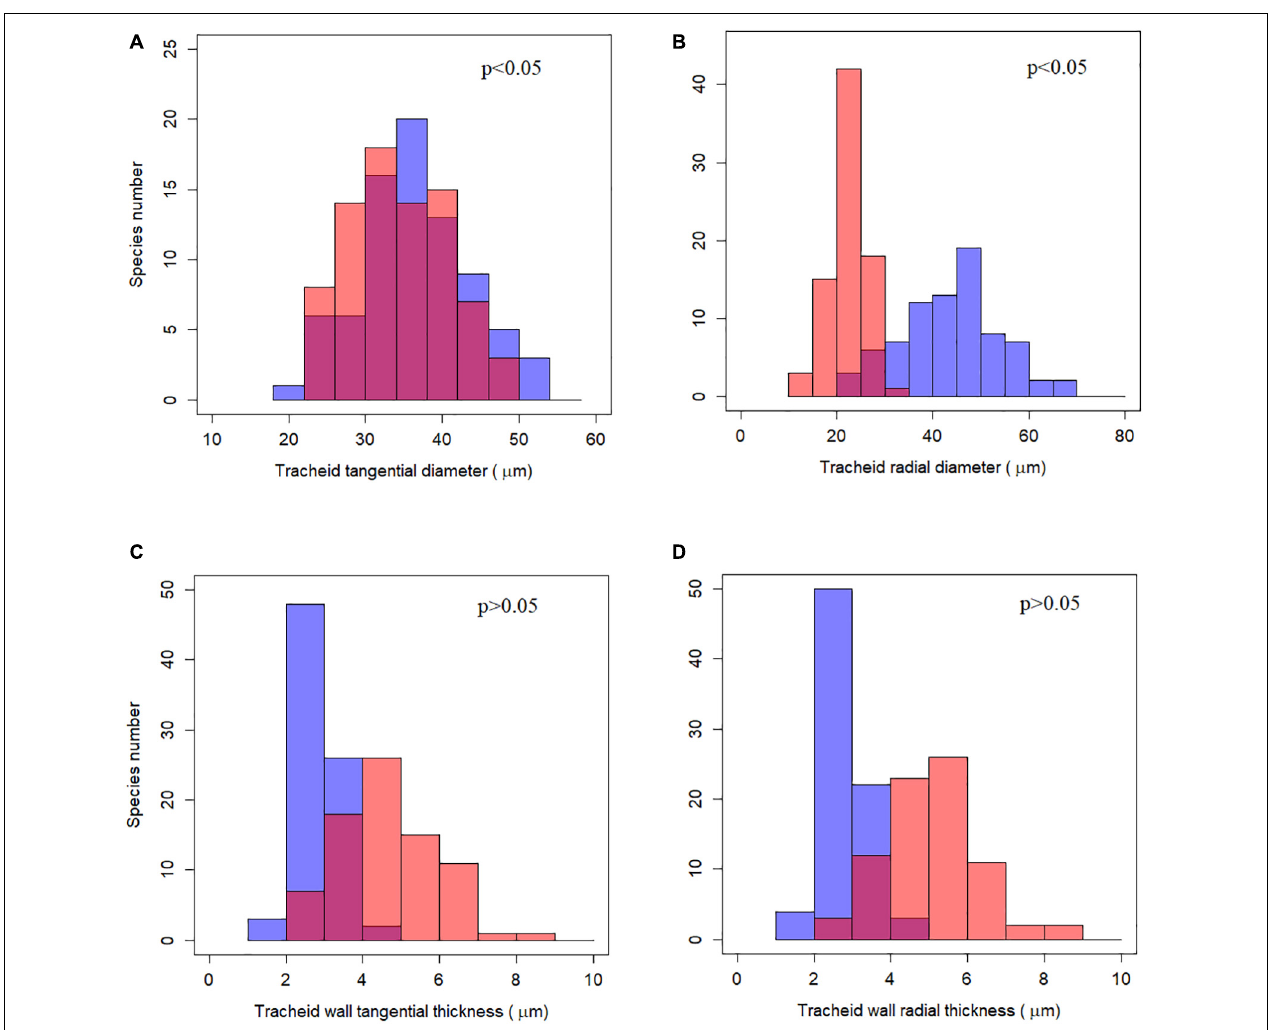
FIGURE 2 | Frequency distribution of tracheid traits and their phylogenetically paired t -test between earlywood and latewood. (A–D) Represent the four tracheid traits studied respectively. Blue bars stand for earlywood and red bars for latewood, purple color indicates overlaying of blue and red bars. The p -value for phylogenetically paired t -test is shown at the up-right corner, indicating that tracheid diameters between earlywood and latewood were significantly different while tracheid wall thickness was